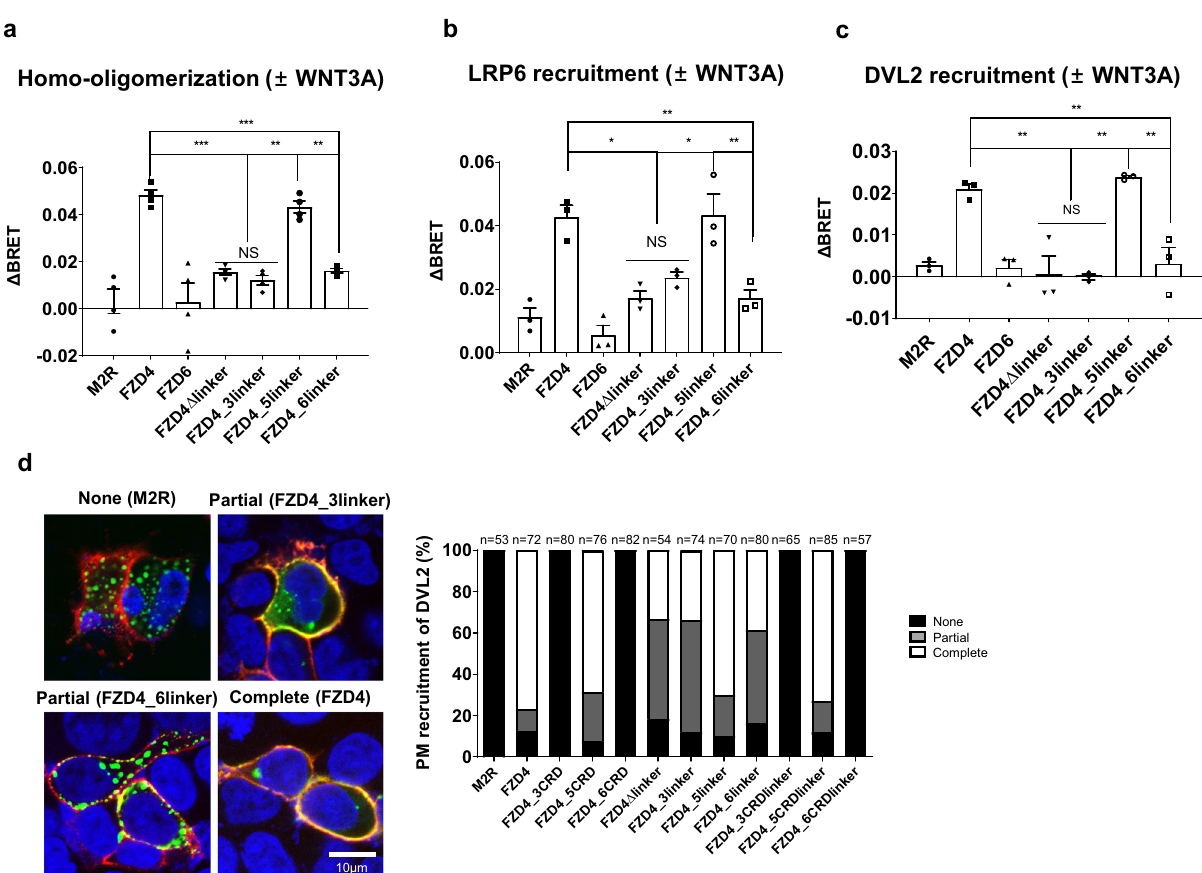
Fig. 4 Reduction of FZD4 oligomerization and LRP6 and DVL2 recruitment by FZD linker mutation. BRET assays were performed with ( a ) FZD-Rluc/ FZD-eYFP, ( b ) FZD-Rluc/LRP6-eYFP, and ( c ) FZD-Rluc/DVL2-eYFP pairs to monitor homo-oligomerization, LRP6 recruitment, and DVL2 recruitment, respectively, in response to WNT3A. A functionally unrelated muscarinic receptor 2 (M2R) was used as a negative control. The titration curve for each pair is demonstrated in Supplementary Figs. 6, 8, and 10, respectively. Bar graphs are drawn using the Δ BRET value for each construct, calculated by subtracting the BRET ratio of afamin-treated sample from that of WNT3A-treated sample. The error bars of all bar graphs are the SEM of three independent experiments. Statistical comparisons were performed using the two tailed t -test. ‘ NS ’ represents ‘ not signi fi cant ’ , ‘ *** ’ represents P < 0.001, ‘ ** ’ represents P < 0.01, and ‘ * ’ represents P < 0.05 for the mediated BRET assay on various FZD linker-swapped mutants. d IF images of cells transfected with M2R, FZD4 wild-type, and FZD4 linker mutants are shown as examples of ‘ none ’ , ‘ partial ’ , and ‘ complete ’ recruitment of DVL2 (Scale bar: 10 µ m). The graph shows the percentage of differential DVL2 recruitment state to FZD. The number of counted cells per condition is